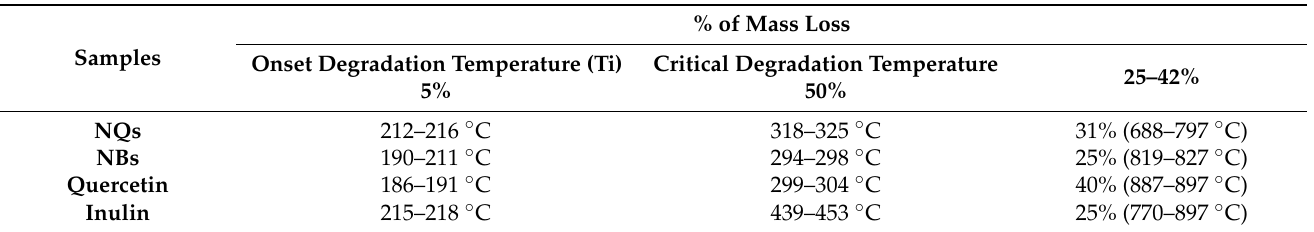
Figure 9. X-ray diffraction (XRD). Pattern of inulin non-charged nanoparticles (NBs) (green line) and inulin nanoparticles loaded with quercetin (NQs) (blue line).